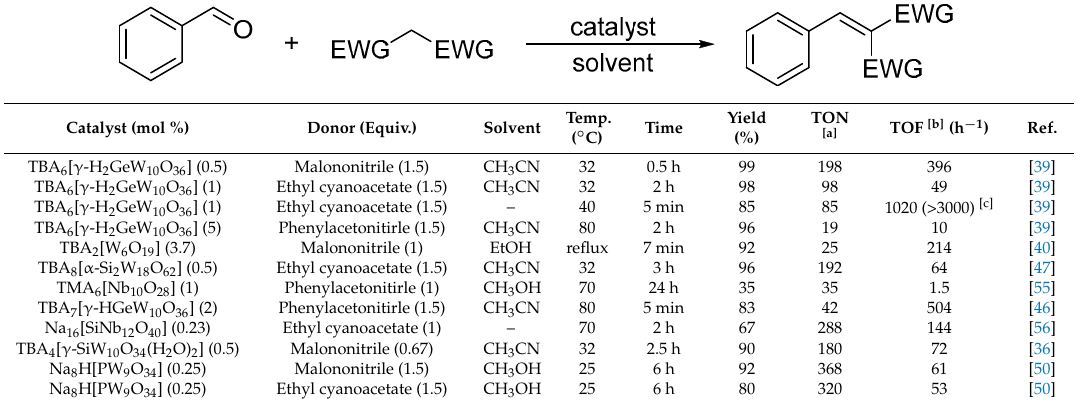
Table 2. Knoevenagel condensation of benzaldehyde with active methylene compounds by POM base catalysts.